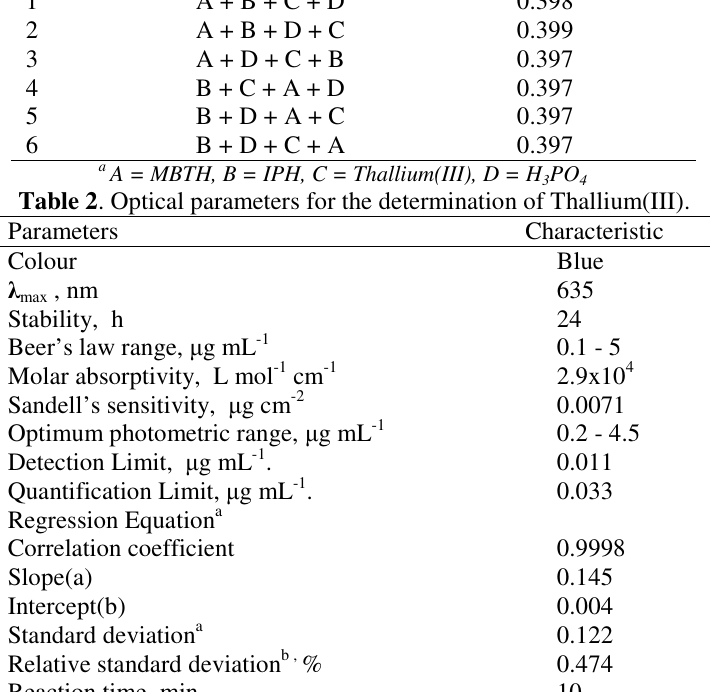
Table 1. Effect of order of reactants addition.